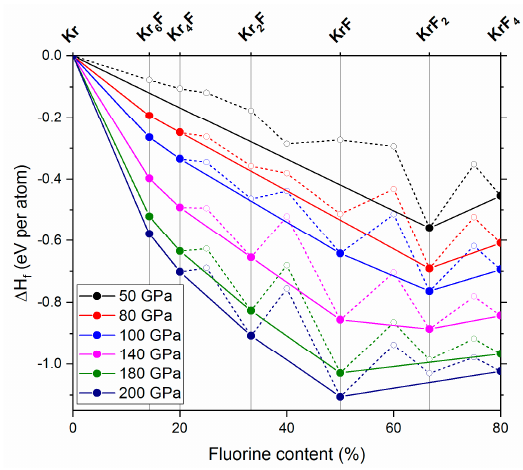
Figure 3. Pressure dependence of the enthalpy of formation per atom of various Kr m F n phases at 50, 80, 100, 140, 180 and 200 GPa. The compounds which stabilize at 80 GPa (Kr 6 F, Kr 4 F), 100 GPa (KrF) and 140 GPa (Kr 2 F) are marked together with KrF 2 and KrF 4 in the upper part of the graph; note that KrF 2 is predicted to decompose above 180 GPa.